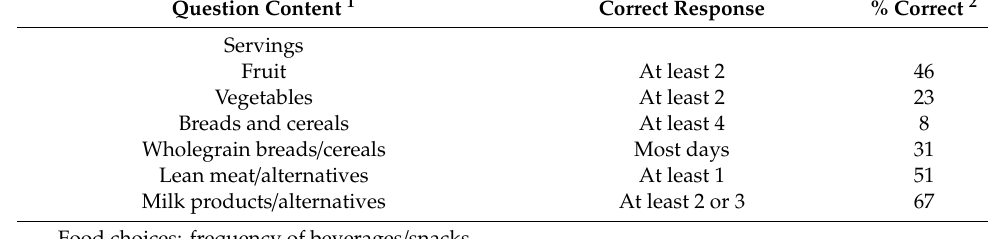
Table 3. Responses of ECEC teachers in New Zealand on nutrition-knowledge items ( n =